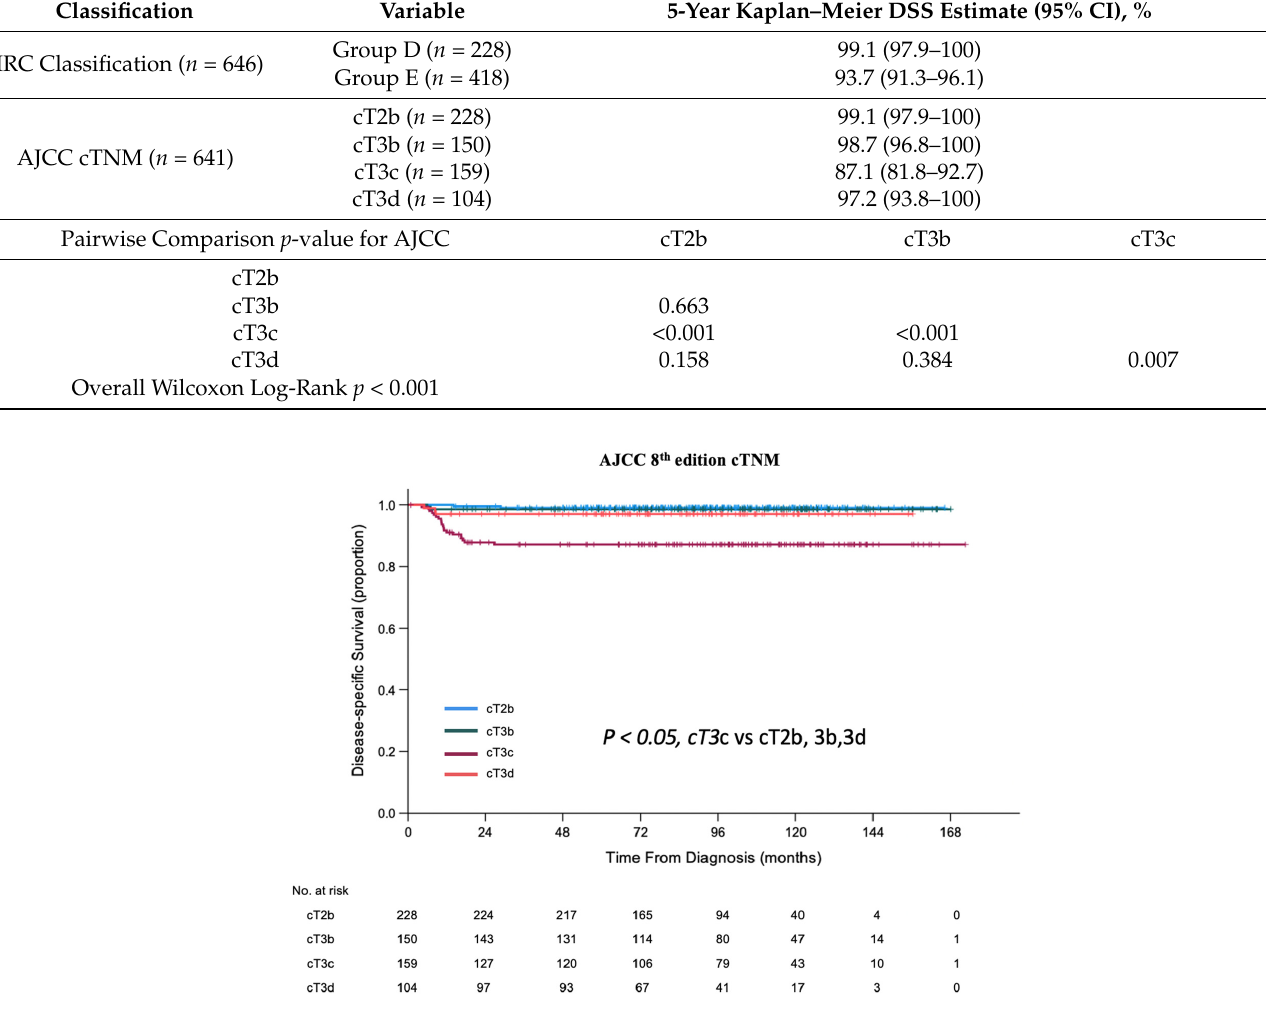
Figure 1. Kaplan–Meier curves of disease-specific survival (DSS) of patients treated with primary enucleation classified by AJCC 8th edition cTNM. There was no significant survival difference between pT2a (100%), pT2b (95.5%), pT3a (100%), pT3b (93.0%), and pT3c/d (92.3%) ( p > 0.05). Patients with pT4 eyes had the worst 5-year DSS (40.9%, p < 0.05 ; Table 3, Figure 2). Table 3. Kaplan–Meier Disease-specific Survival Pairwise Comparison for AJCC Pathological Staging. Classification